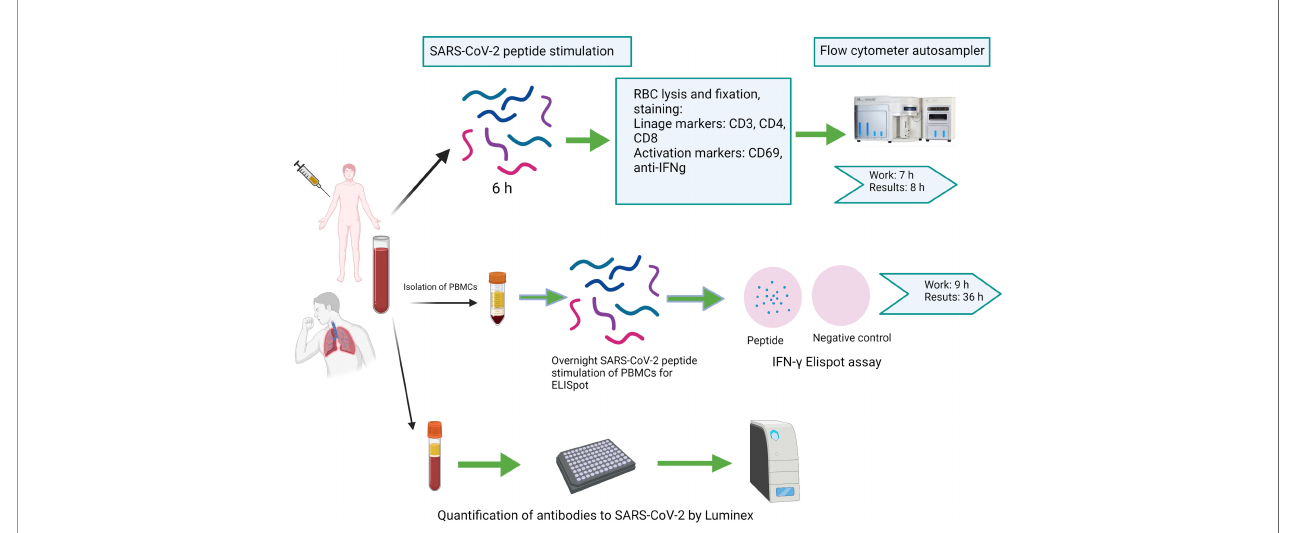
FIGURE 1 | Schematic representation of the work fl ow for direct peptide stimulation of whole peripheral blood by CoVITEST, IFN- g ELISpot or antibody quanti fi cation by Luminex ® (Created